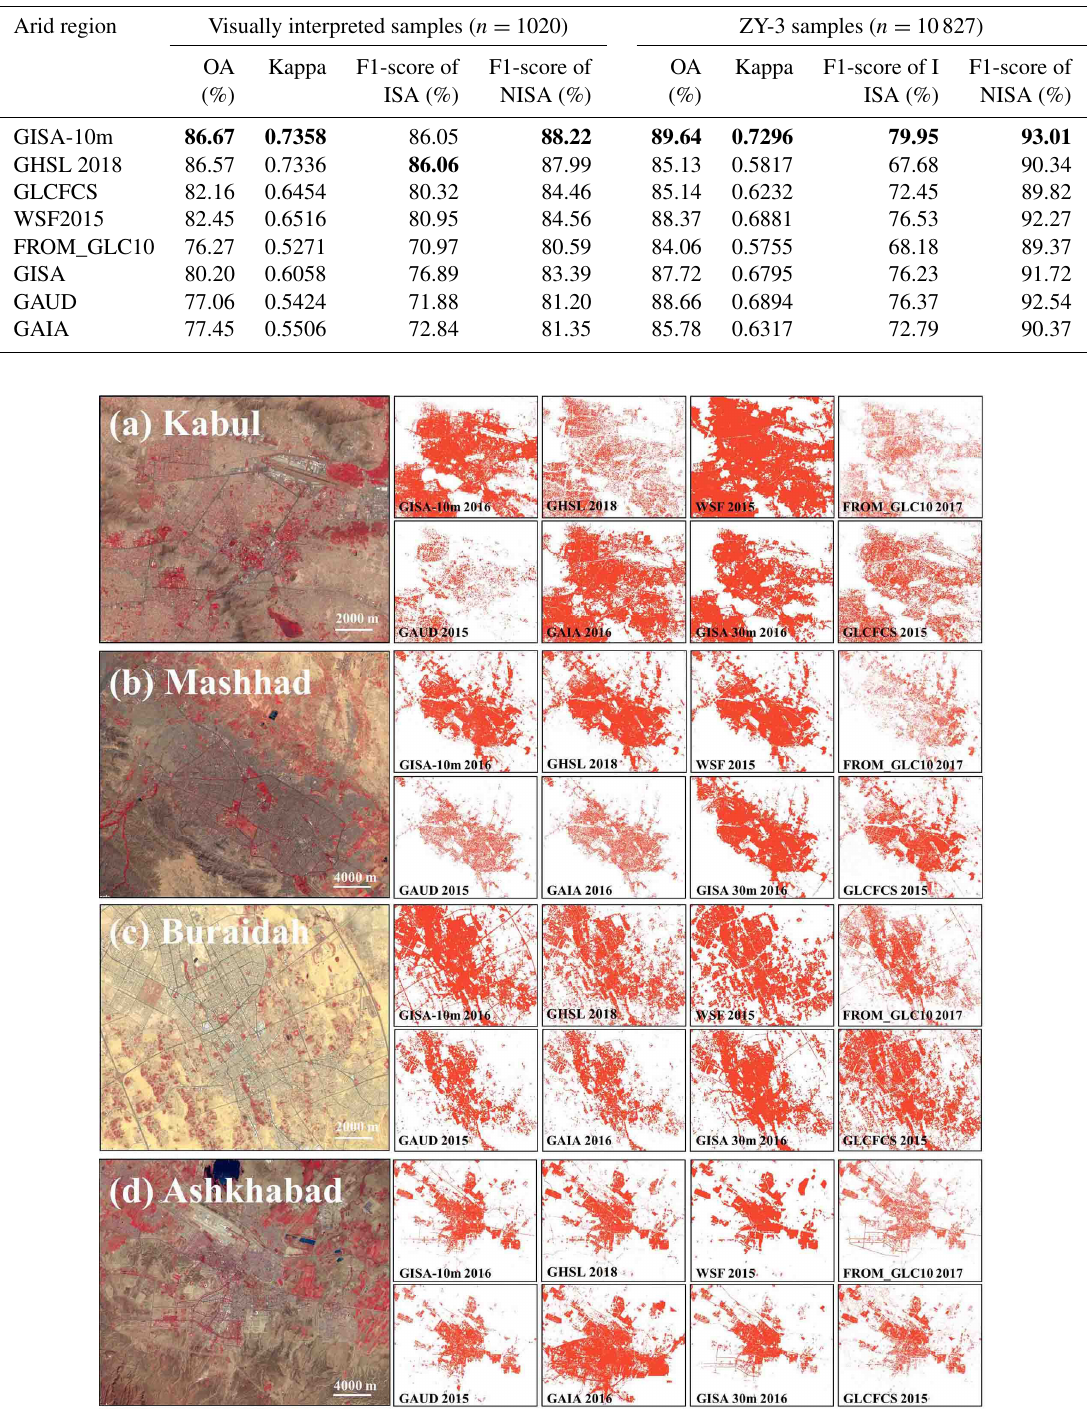
Figure 7. Comparison of the GISA-10m and the other datasets over arid regions in (a) Kabul, Afghanistan; (b) Mashhad, Iran; (c) Buraidah, Saudi Arabia; and (d) Ashkhabad, Turkmenistan. The illustration is of Sentinel-2 images with a false-color combination (R: NIR, G: red, B: green) to enhance the